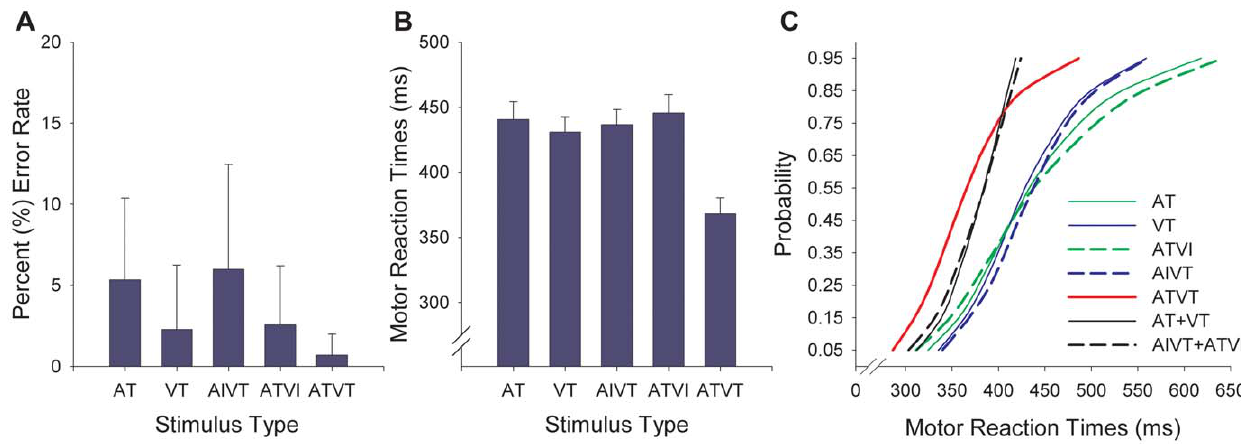
Figure 1. Behavioral measures of multisensory facilitation. A . Percent (%) error rate ( + SD ) for unisensory targets (AT and VT) and audiovisual stimuli with target and irrelevant components: ATVI (auditory target and visual irrelevant), AIVT (auditory irrelevant and visual target) and ATVT (audiovisual dual targets). B . Mean motor reaction times ( + SEM ) for unisensory (AT and VT) and multisensory stimuli (ATVI, AIVT and ATVT). C . Cumulative density functions (CDFs) of motor reaction times (RTs) for AT, VT, ATVI, AIVT, ATVT stimuli, the summed CDFs for unisensory stimuli (AT + VT) and multisensory stimuli with single target components (AIVT + ATVI).